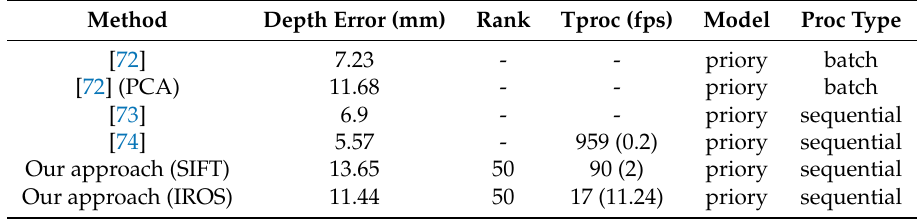
Table 8. Comparative results with other state-of-the-art algorithms in the Kinect paper